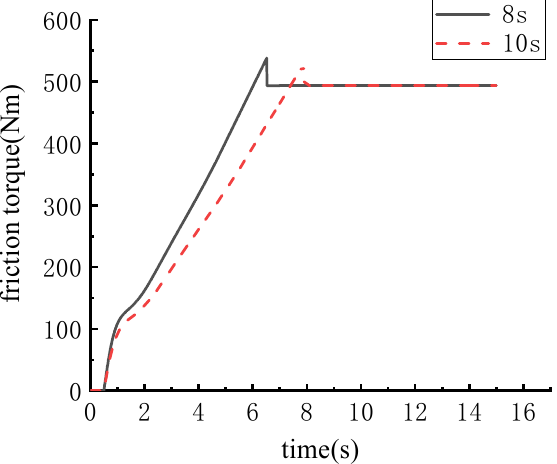
Figure 12. Frictional torque curve for conventional fi xed slope loading.